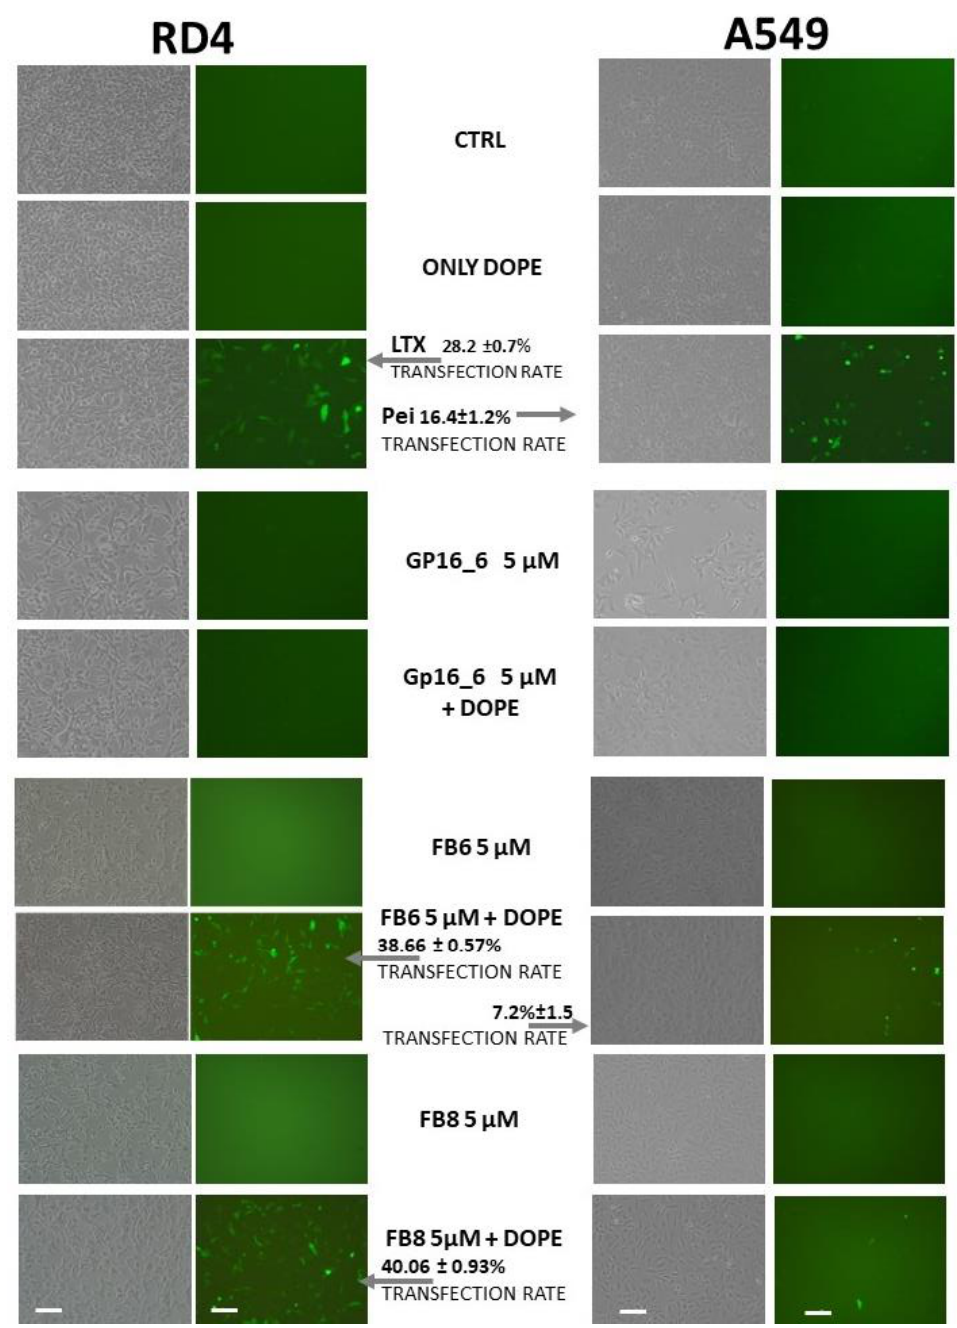
Figure 6. Transfection of RD4 ( left ) and A549 cells ( right ) by GP16_6, FB6 and FB8 5 μM. For each kind of cells, on the left, phase contrast and, on the right, fluorescence microscope observation of the transfected cells (as shown by green cells expressing EGFP) is shown. The experiments were done with the surfactant alone and with surfactant:DOPE = 1:2. Cells are not transfected with DOPE alone (see [14,18,21]). Transfection rate of FB8 5 μM + DOPE is not indicated because it is <1%.The scale bars = 20 μm are common for all of the micrographs.